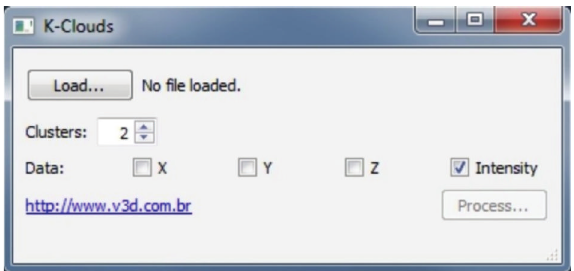
Figure 8: K-Clouds interface. The software allows the user to define the number of clusters linked with the intensity values (I) or spatial values (XYZ) coordinates.